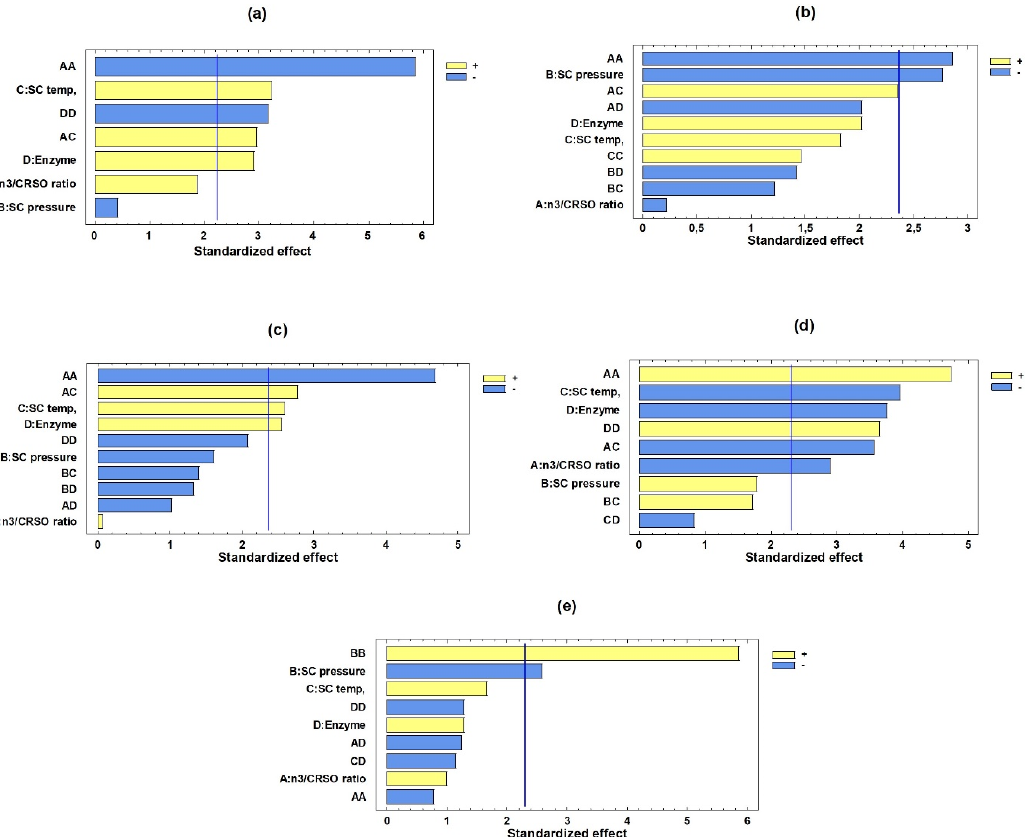
Figure 1. Effect of the n -3/CRSO ratio, SC temperature, SC pressure, and amount of enzyme on the SAcyl synthesis process. Standardized Pareto diagrams showing the influence of the independent variables on the response variables (the blue line indicates the p < 0.05 confidence interval). Panels ( a – e ), represent EPA, DHA, EPA + DHA, PA, and EPA/DHA in sn -2, respectively.